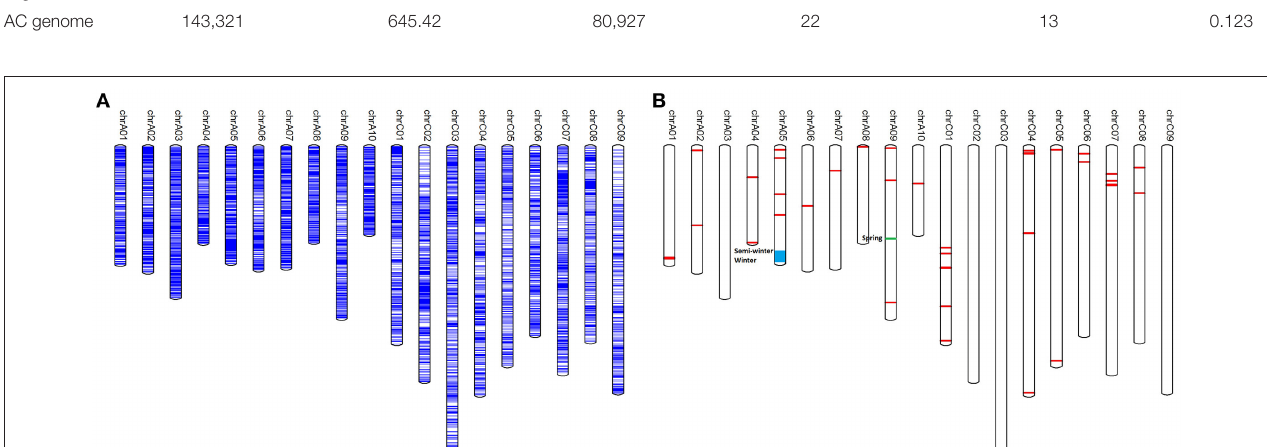
FIGURE 1 | Distribution of SNP hotspots and SNP-rich regions on chromosomes of B. napus . (A) The distribution of SNP hotspots on the genome; (B) The distribution of SNP-rich regions on the genome in B. napus .